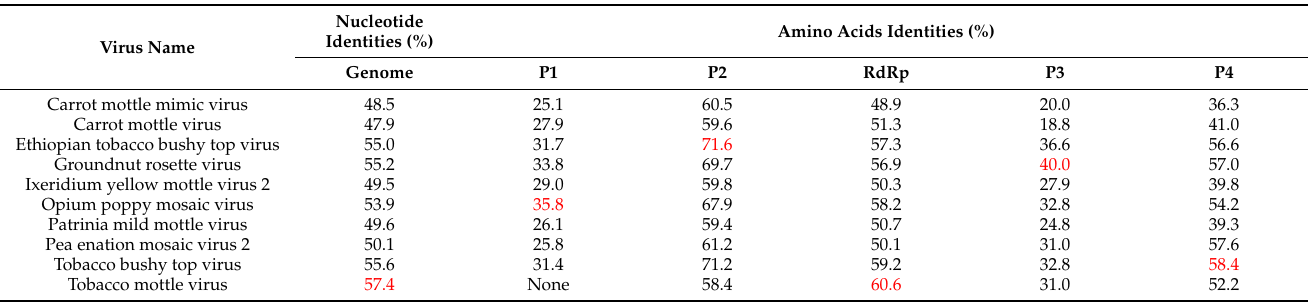
Table 1. Genomic RNA and viral protein sequence similarities between PSCYV and other ten members in the genus Umbravirus